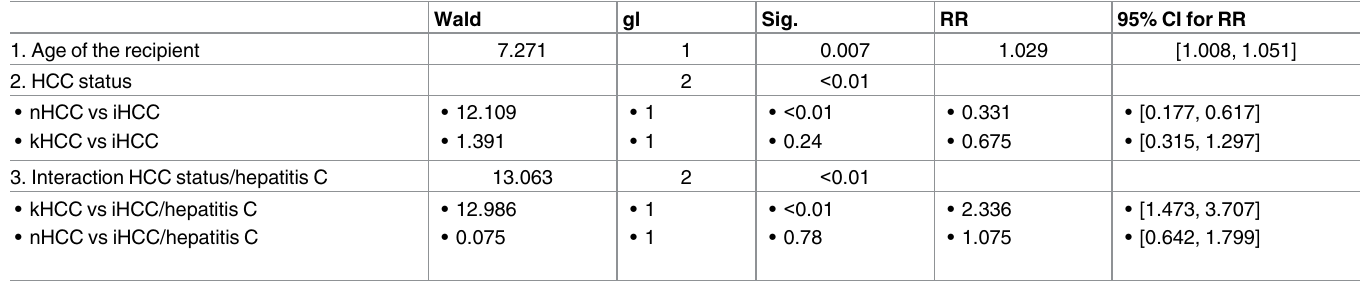
Table 3. Multivariate Cox’s regression showing independent predictors of overall survival after liver transplantation. Wald gl Sig. RR 95% CI for